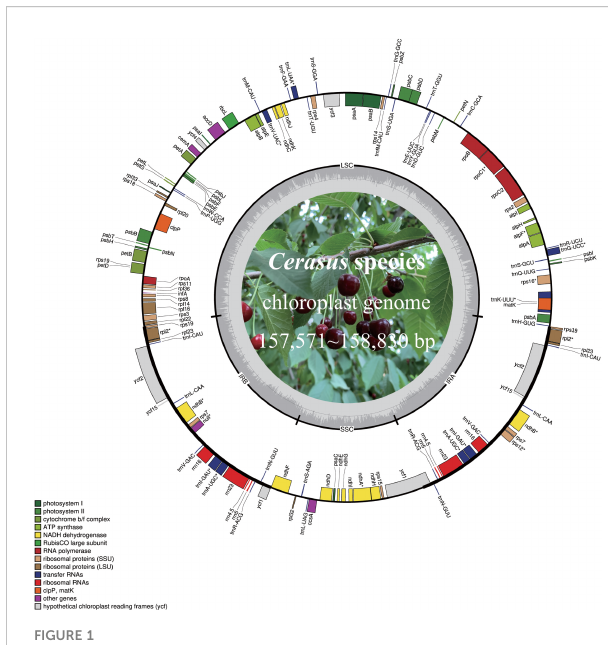
FIGURE 1 Chloroplast genome map of Cerasus species. Genes on the inside of the large circle are transcribed clockwise and those on the outside are transcribed counterclockwise. The genes are color-coded based on their functions. The dashed area represents the GC composition of the chloroplast genome. LSC, large single copy region; IR, inverted repeat; SSC, small single copy